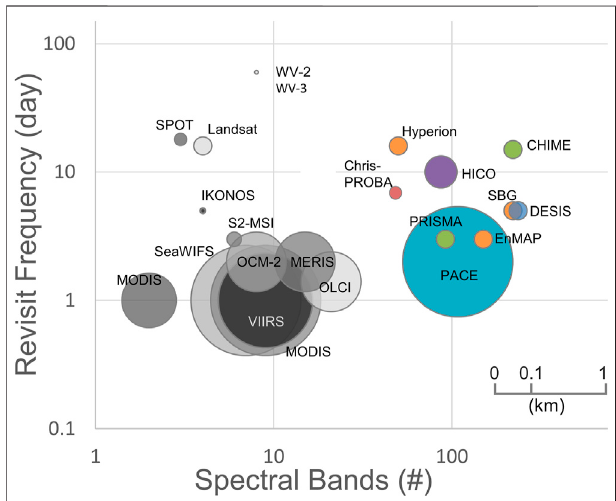
FIGURE 1 | Architecture of various international missions showing the tradeoff between number of spectral bands, revisit frequency ( X and Y axes, respectively)and thespatialfootprint(approximated asthesize ofcircle).Gray representmulti-spectralmissionsandcolorsrepresentthehyperspectral missions. Modi fi ed from Hestir et al.